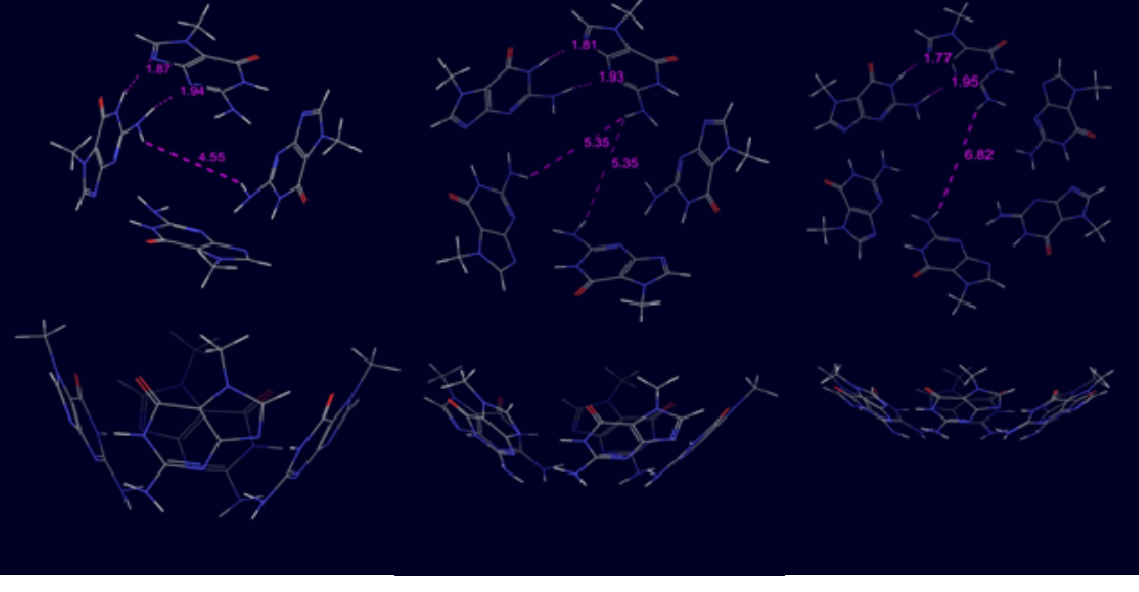
Table 1. Bonding energies and average H-bond energies (in kcal/mol) of the 4-, 5- and symmetry) and the planar ribbon structures 6-membered m 7 G rings (with and without C s with 4, 5, 6 and 7 units. The number of H-bonds in the concerned structure is also shown. Tetramer Pentamer Hexamer